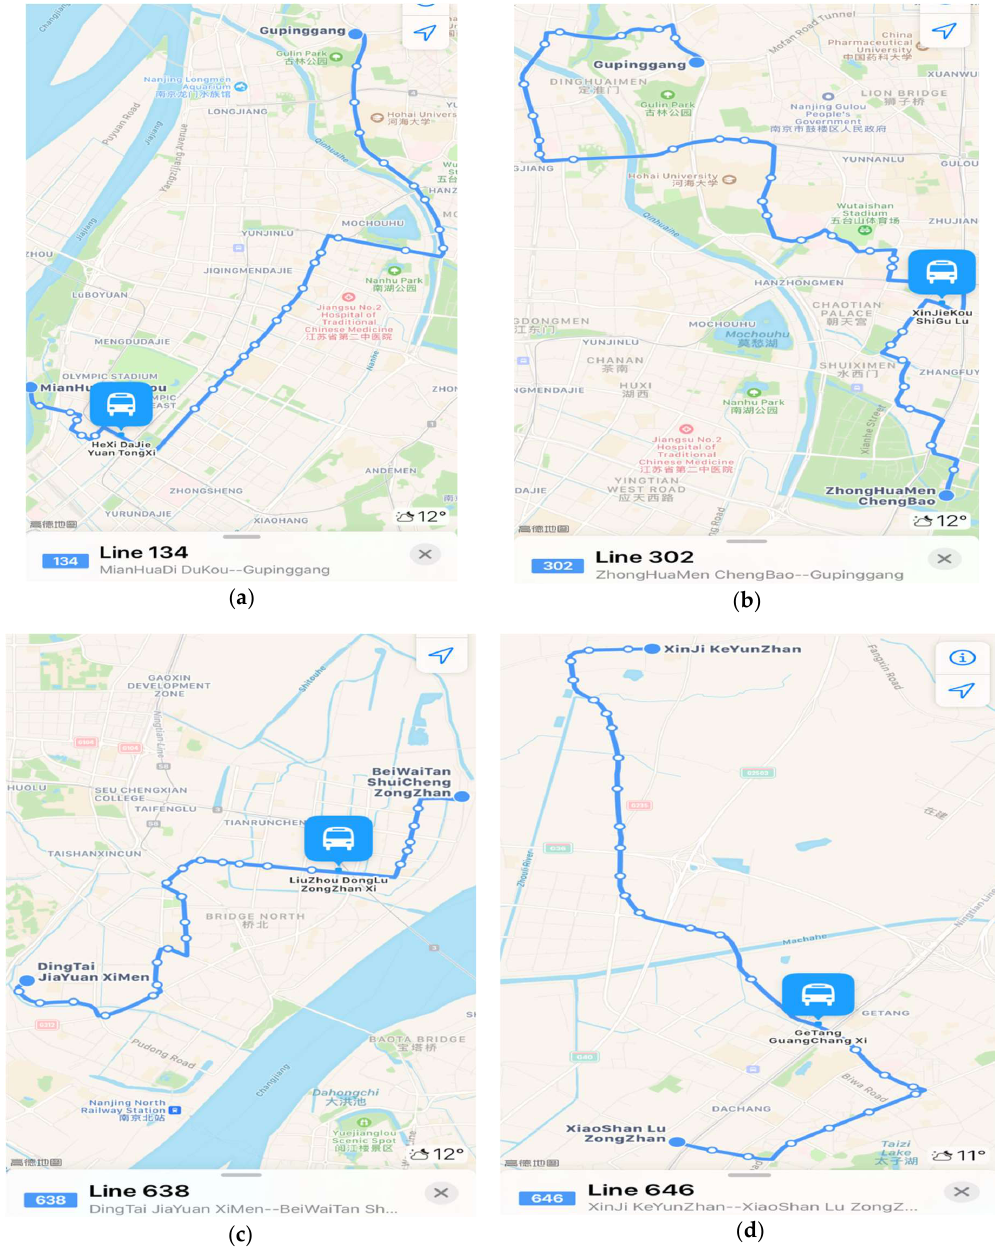
Figure 5. ( a ) Route 134W; ( b ) Route 302W; ( c ) Route 638W; ( d ) Route 646W.